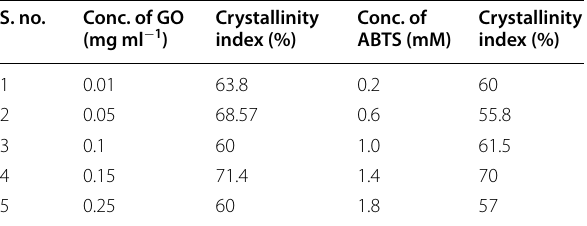
Table 1 XRD crystallinity indices for different concentrations of GO and ABTS when combined with laccase S.